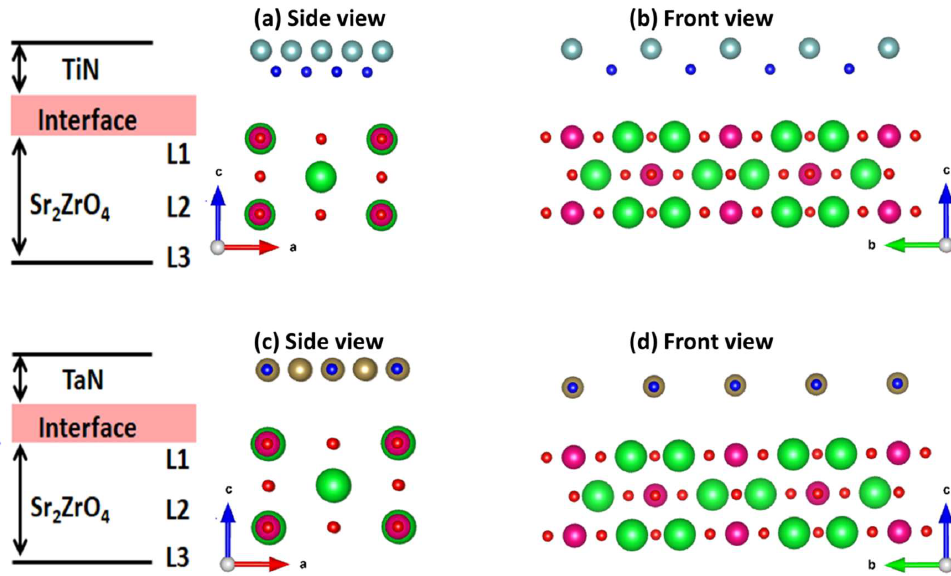
Figure 2. Side view and front view of ( a , b ) Sr 2 ZrO 4 /TiN and ( c , d ) Sr 2 ZrO 4 /TaN assuming the layers stacked along c axis. Three layers of the considered Ruddleson–Popper perovskite material (Sr 2 ZrO 4 ) and interface are labeled as L1, L2, L3 and interface, respectively. Color scheme of the atoms is same as described earlier in Figure 1.